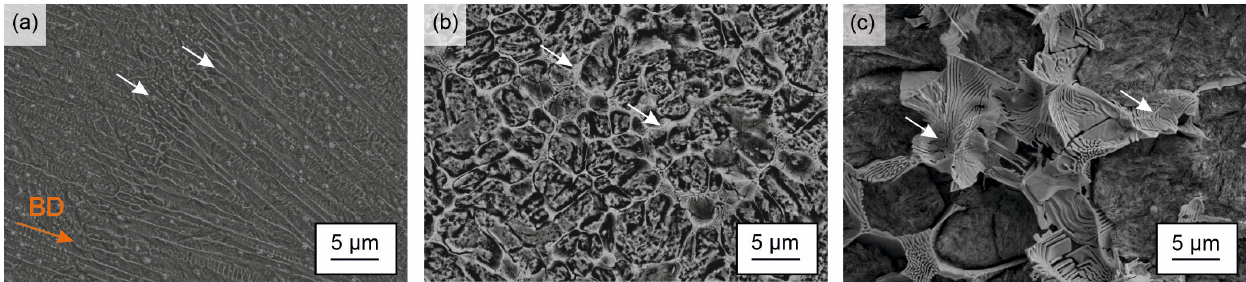
Figure 1. SEM images of the deep etched Fe85Cr4Mo8V2C1 steel processed by: ( a ) laser powder bed fusion (BD: building direction); ( b ) centrifugal casting; and ( c ) gravity casting. The carbide network is marked by arrows.